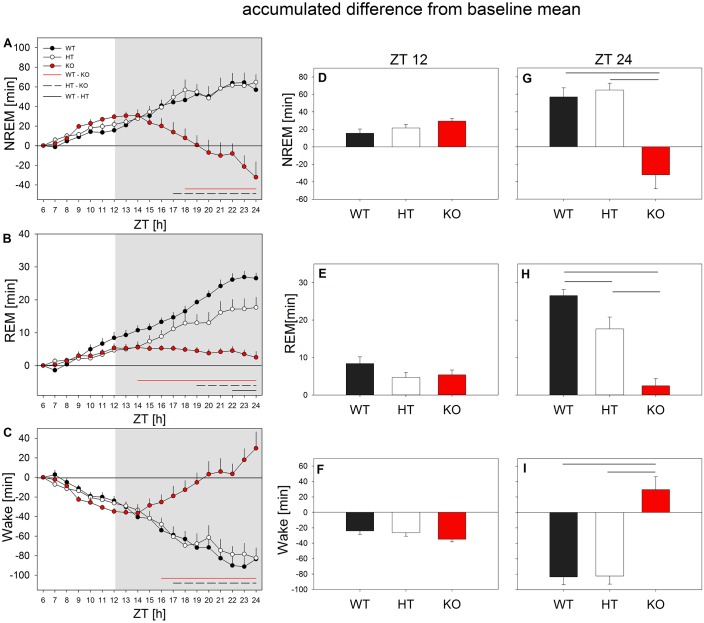
mGluR5 modulate the response to sleep deprivation in mice.All mice showed a NREM and REM sleep rebound at the cost of wakefulness in the 6 hr light phase of recovery. During the recovery dark phase, KO mice (red circles) lost NREM and REM sleep, while increasing wakefulness. Left panel: Accumulated difference from baseline (i.e. mean of baselines) across the 18 hr recovery period. Hourly differences in NREM sleep (A), REM sleep (B) and wakefulness (C) from the baseline value were continuously summed up to achieve the accumulated difference from baseline (n = 8 mice/genotype, mean + SEM). Horizontal lines represent Holm-corrected t-tests (p < 0.05), following significant ‘genotype’ effects in one-way ANOVAs performed at each time point (p < 0.05); WT vs. KO (red line), HT vs. KO (dotted line), WT vs. HT (black line). Middle and right panels: Accumulated mean changes in NREM sleep, REM sleep and wakefulness from baseline to recovery at the end of the 6 hr light phase (ZT12; i.e. accumulated differences of ZT7 – ZT12) (D-F) and at the end of the 18 hr recovery period (ZT24; i.e. accumulated differences of ZT7 – ZT24) (G-I). No significant effects were observed during the light period. During the dark period of recovery KO mice (red bars) differed significantly from the littermates in their response to sleep deprivation. Horizontal lines represent significant differences between genotypes in Holm-corrected t-test following significant ‘genotype’ effect in one-way ANOVA: NREM sleep: p < 0.002 for WT vs. KO and p < 0.001 for HT vs. KO; REM sleep: p < 1e-6 for WT vs. KO, p < 0.004 for HT vs. KO and p < 0.04 for WT vs. HT; Wake: p < 0.0004 for WT vs. KO and for HT vs. KO.10.7554/eLife.28751.016Figure 6—source data 1.Excel file with one data sheet containing the numerical values of each figure panel (A-I) of Figure 6.